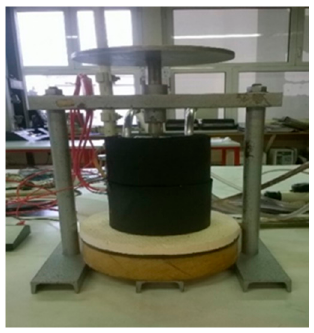
Figure 2. Apparatus for measuring the thermal conductivity.